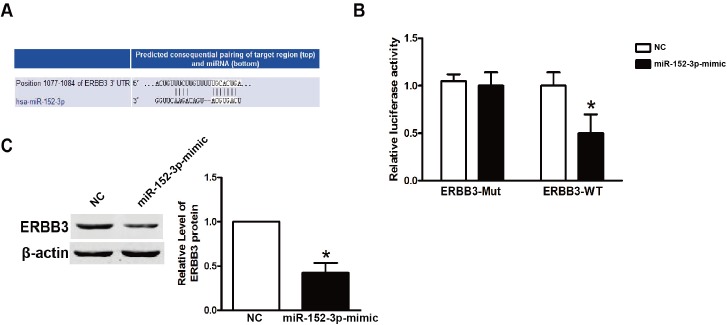
The mir-152-3p negatively regulates ERBB3 by binding to the 3'-UTR of ERBB3.A. Putative mir-152-3p-binding site at the 3'-UTR of ERBB3(TargetScan). B.The luciferase assay of HEK293T cells. The relative luciferase activity was determined after the described reporter constructs (pMIR-ERBB3-WT or pMIR-ERBB3-Mut) were co-transfected with the NC or mir-152-3p mimic into HEK293T cells. The luciferase activity was normalized to Renilla luciferase activity. Columns, mean; bars, standard deviation. **P<0.01. C. The mir-152-3p negatively regulates protein expression of ERBB3 in TPC-1 cells. β-Actin was used as an internal control for ERBB3.